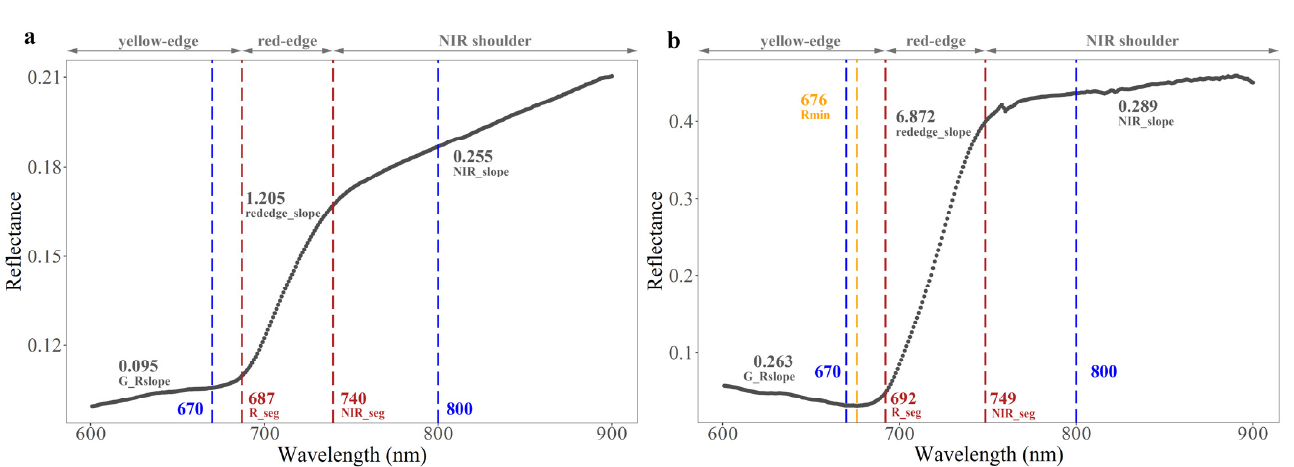
Figure 2. Illustration of a novel method for extracting spectral parameters of yellow-edge, red-edge and NIR shoulder (G_Rslope, rededge_slope, NIR_slope, Rmin, R_seg and NIR_seg refer to the slope of yellow-edge, the slope of red-edge, the slope of NIR shoulder, red valley position, R segmentation and NIR segmentation, respectively): ( a ) Spectra collected in Grassland National Park (GNP), Canada (i.e., Red valley position is not detected due to the impact of dead materials); ( b ) Spectra measured in the subalpine meadow in Wuyishan National Park (WNP), China. Table 2. Spectral parameters of yellow-edge, red-edge and NIR shoulder.